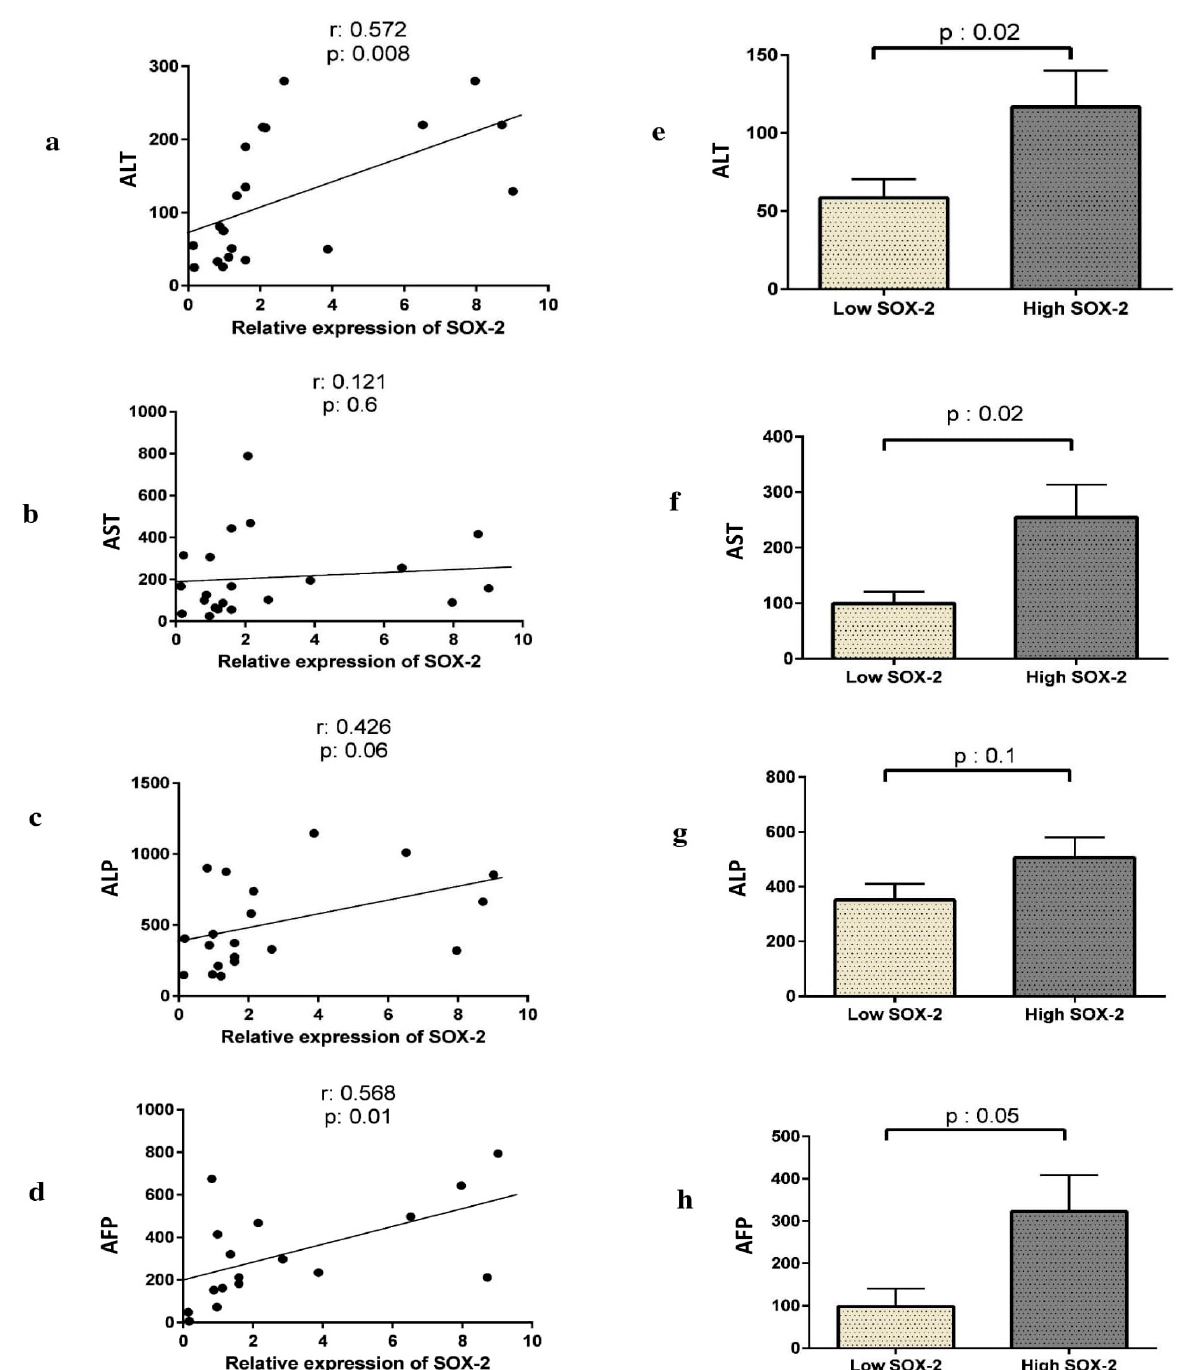
Figure 2. Correlation between SOX2 expression and liver function activity in HCC patients. The expression of SOX2 was positively correlated with ALT ( a ) and AFP ( d ). Correlation with AST and ALP was marginally significant ( b , c ). Expression of SOX2 and liver function activity in HCC patients. ALT ( e ), AST ( f ), and AFP ( h ) levels were significantly increased in high-SOX2 compared to low-SOX2 expression patients. There was no statistically significant association between SOX2 expression and ALP ( g